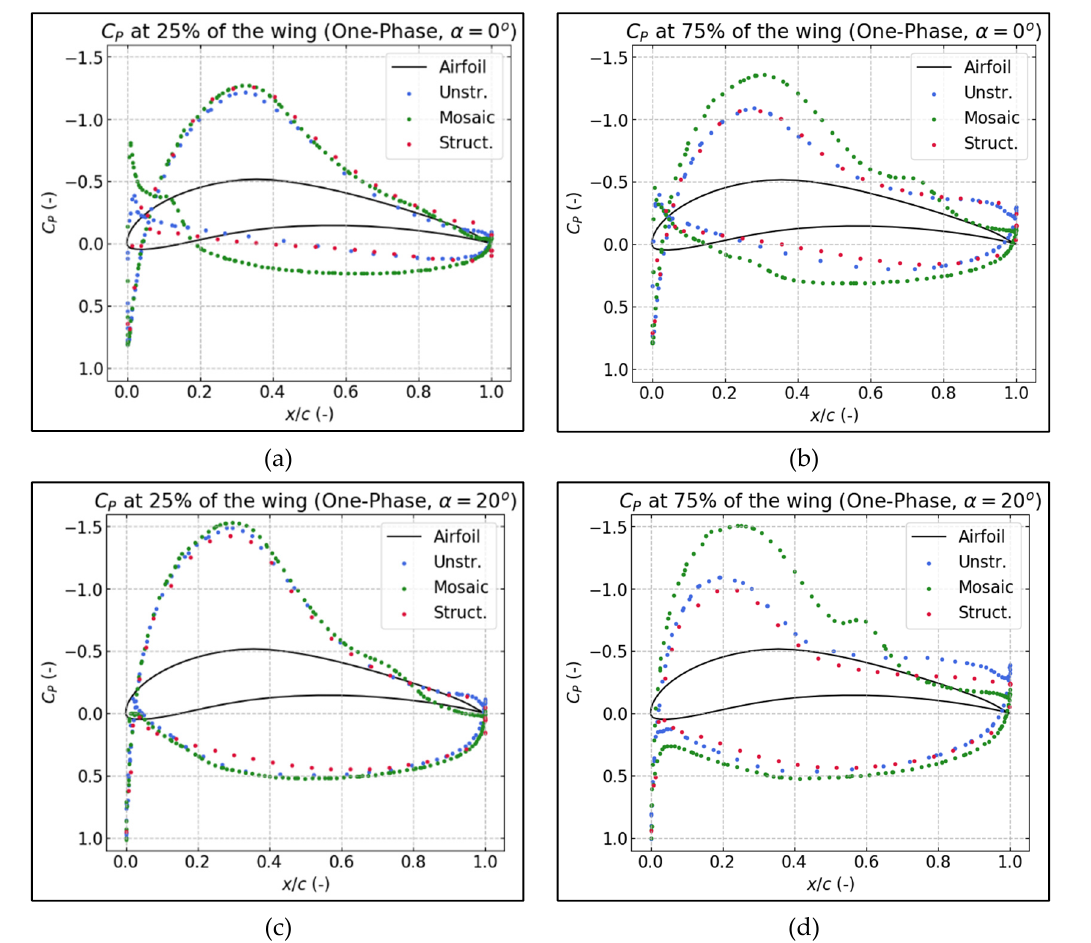
Figure 12. Coefficient of pressure distribution around airfoil after three meshes in one-phase flow ( a ) 25% of wingspan, AoA 0 degrees ( b ) 75% of wingspan, AoA 0 degrees ( c ) 25% of wingspan, AoA 20 degrees ( d ) 75% of wingspan, AoA 20 degrees.